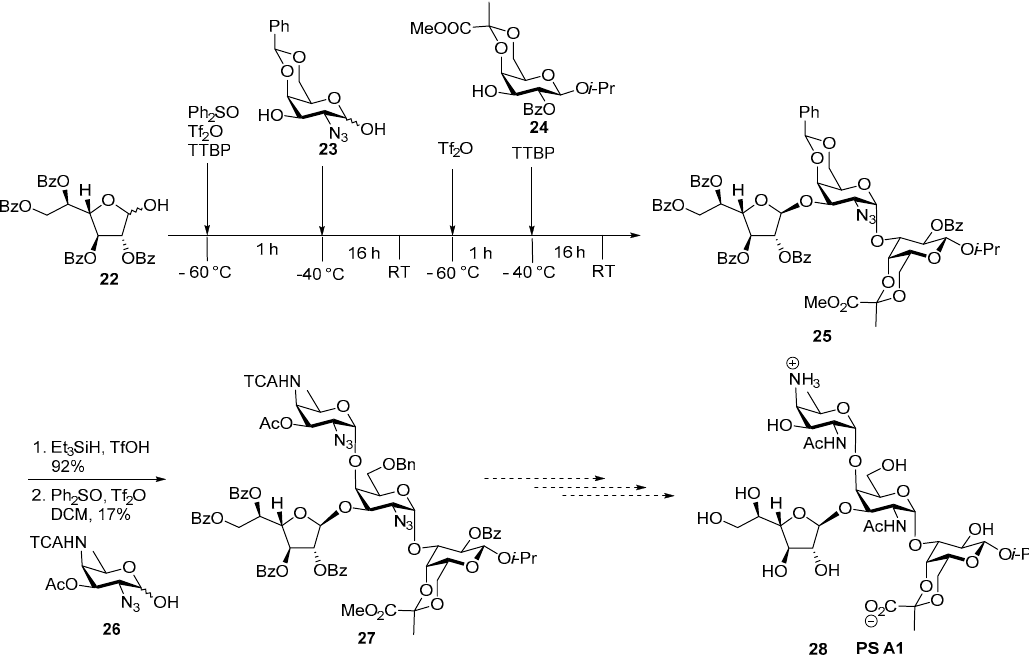
Scheme 4. Van der Marel’s assembly of protected tetrasaccharide repeating unit of